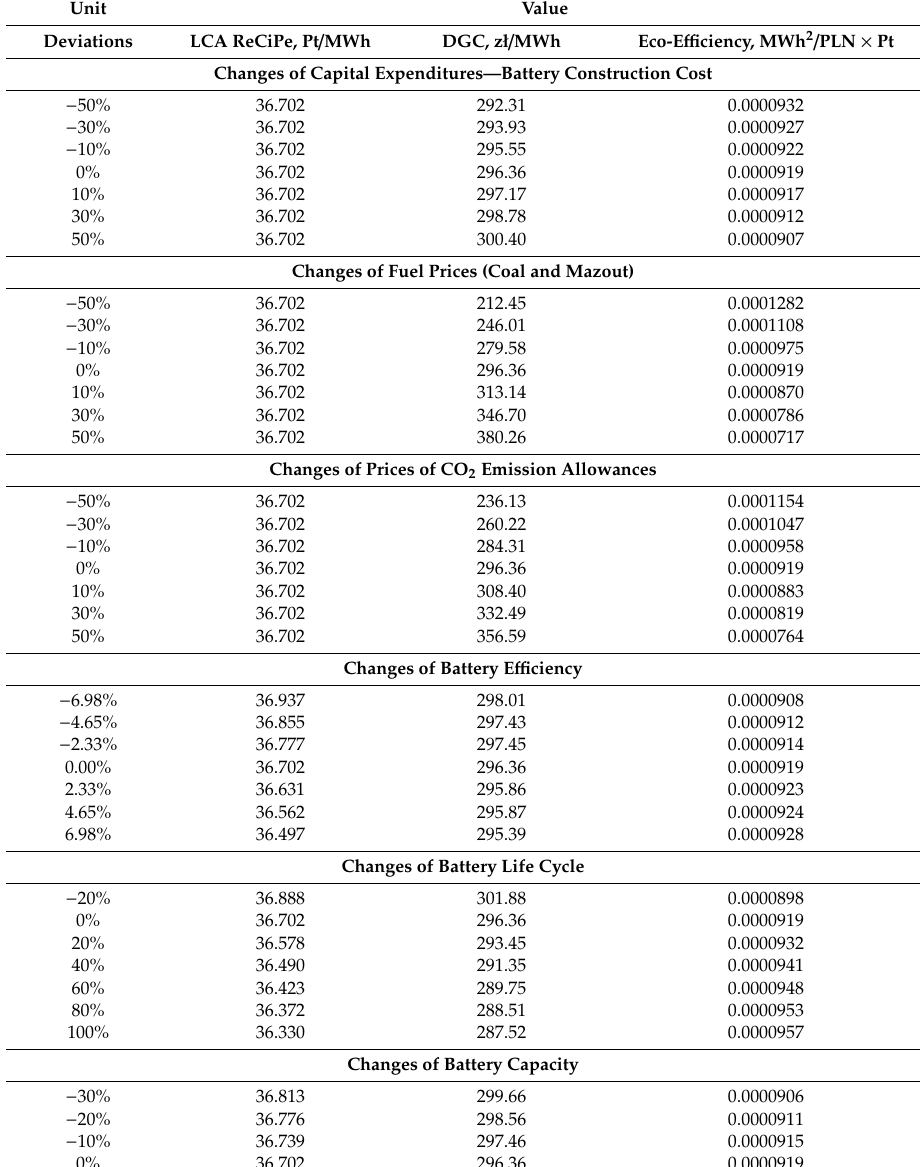
Table 6. The results of the sensitivity analysis of electricity production technology in a coal-fired power plant using a